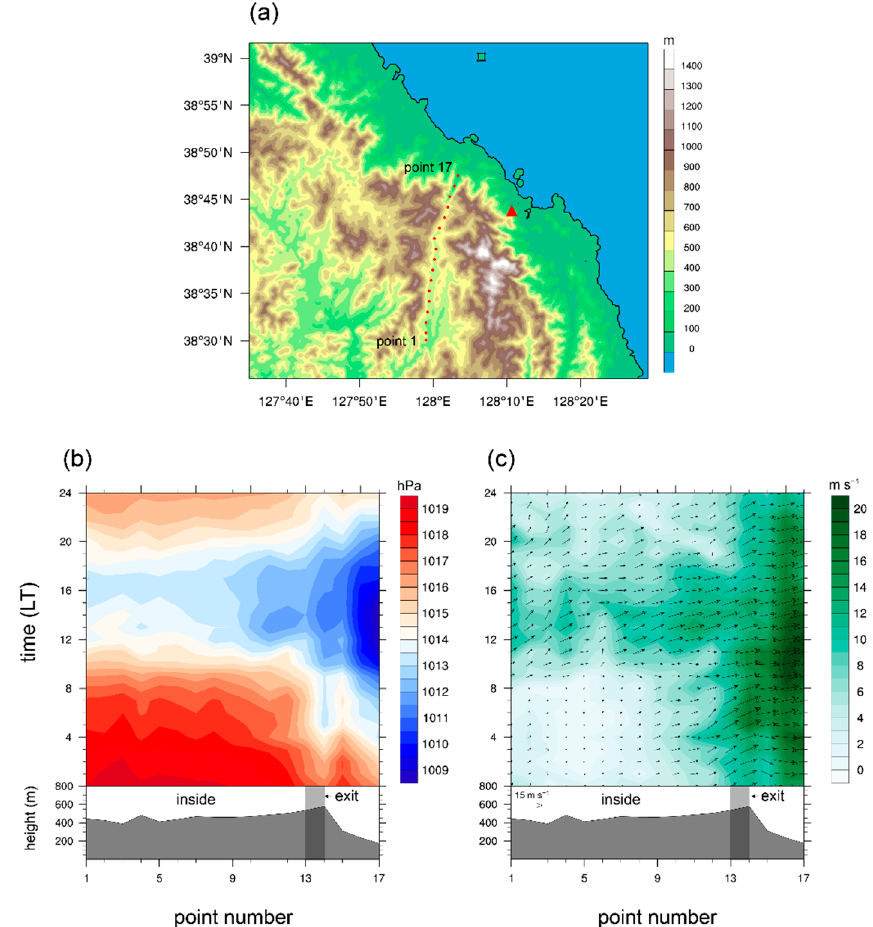
Figure 9. ( a ) Terrain height (m) in A1. Hovmöller diagrams of the ( b ) sea-level pressure and ( c ) 10-m wind speed and 10-m wind vector at the 17 points. The red dots in Figure 9a indicate the selected 17 points in the gap. Vertical cross sections of the terrain height at the 17 points are added in the lower panels of Figure 9b,c. The red triangle indicates the location of Jangjeon station.